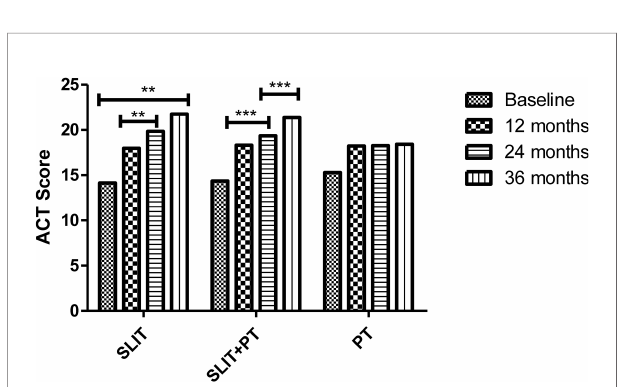
FIGURE 2 | Asthma Control Test (ACT) of three treatment groups at different stages. ** denotes level of statistical signi fi cance which was p = 0.006. *** denotes level of statistical signi fi